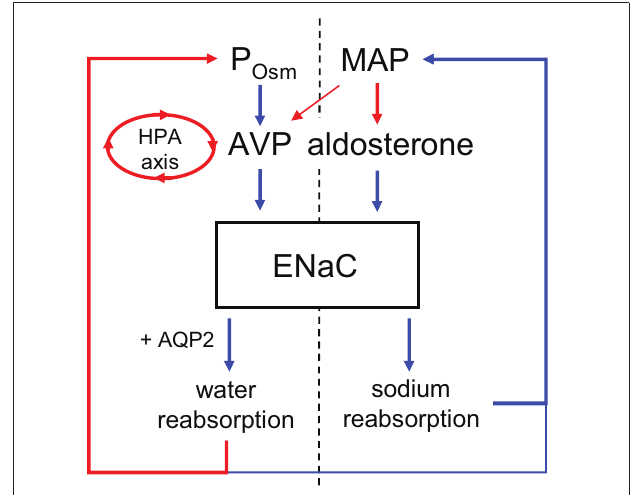
FIGURE 1 | Regulation of ENaC by aldosterone and vasopressin. Vasopressin release is stimulated primarily by increases in plasma osmolality but also by decreases in mean arterial pressure and is also under feedback control by the hypothalamic-pituitary-adrenal (HPA) axis as mediated by glucocorticoids. Positive and negative relations are indicated by blue and red, respectively. Weaker regulation indicated with narrower